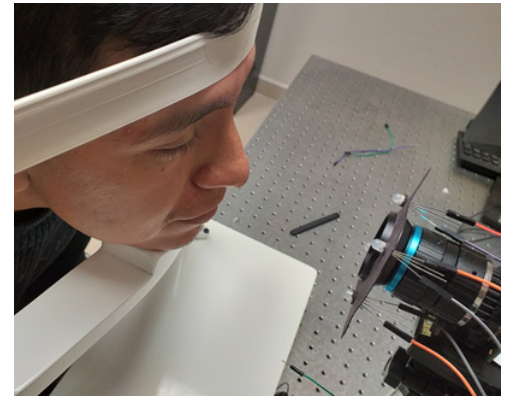
Figure 4. Subject under